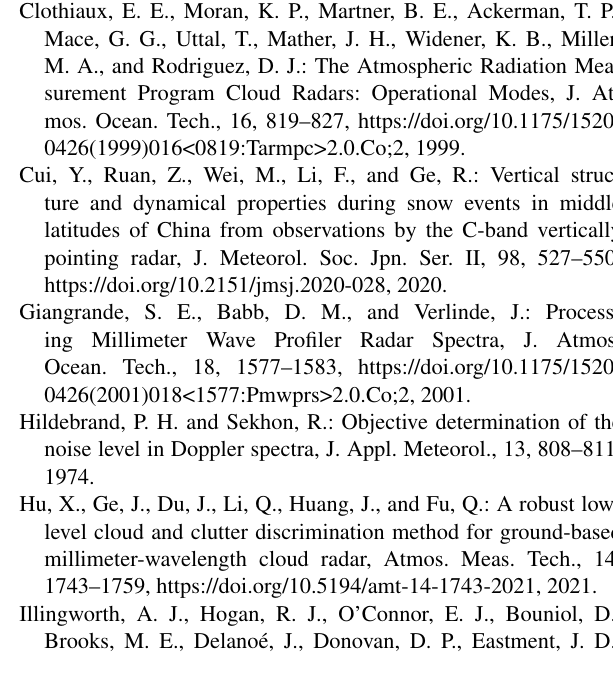
Data availability. The data used in this study can be made available upon request to the corresponding